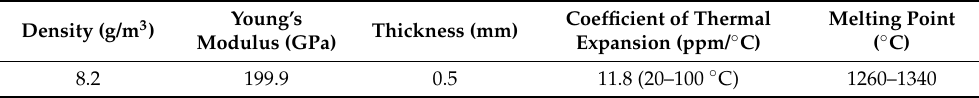
Table 1. The properties of the GH4169 superalloy steel substrate.